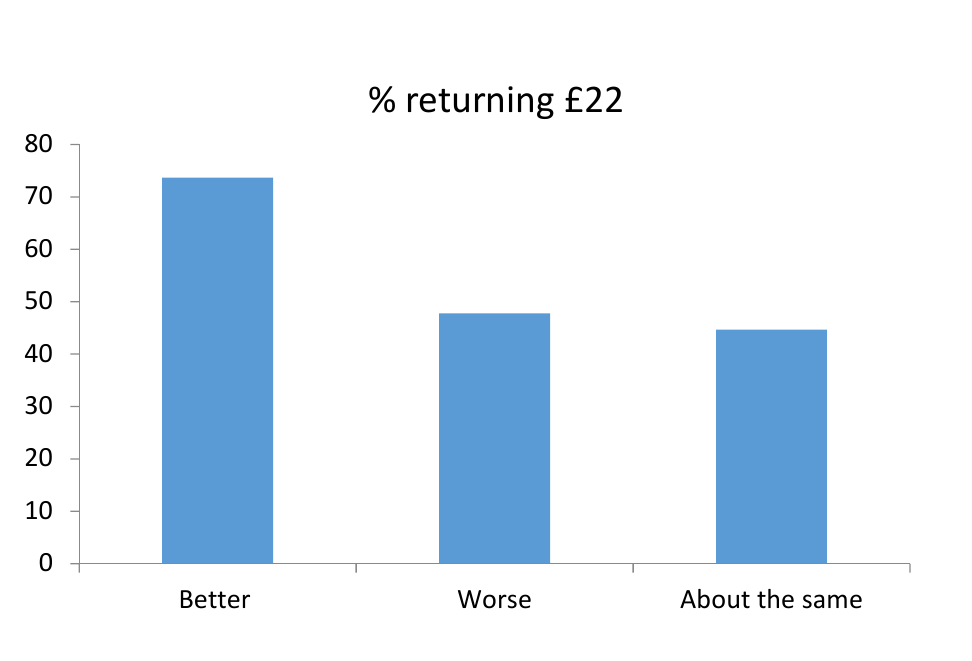
Figure 3: Perceived change in financial situation between 2006 and 2007 and